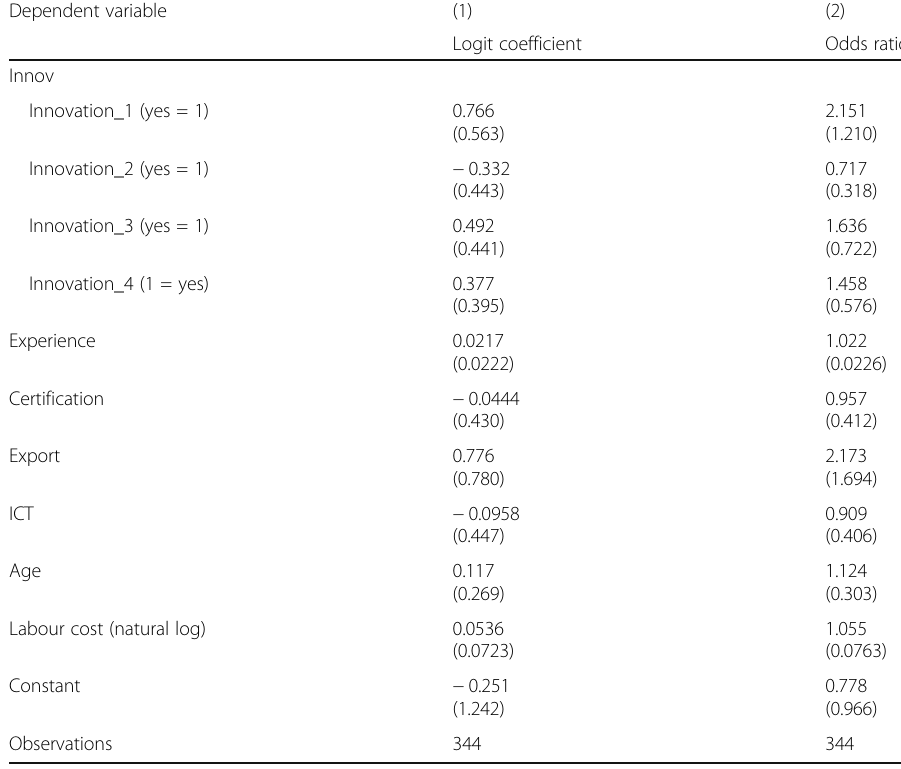
Table 6 Comparison of firms with missing and non-missing sales per worker